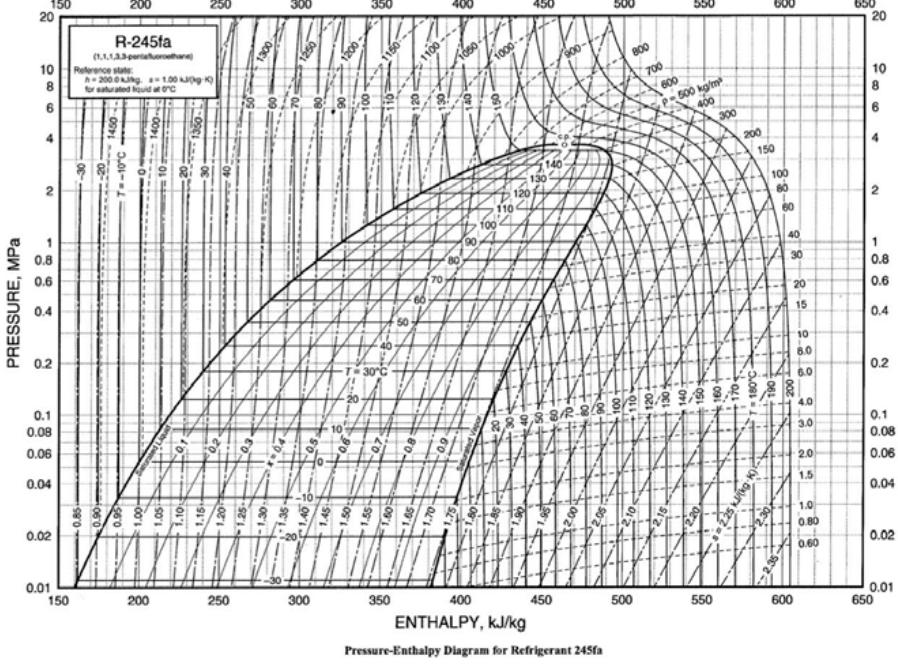
Figure 1. R245fa p-h diagram.